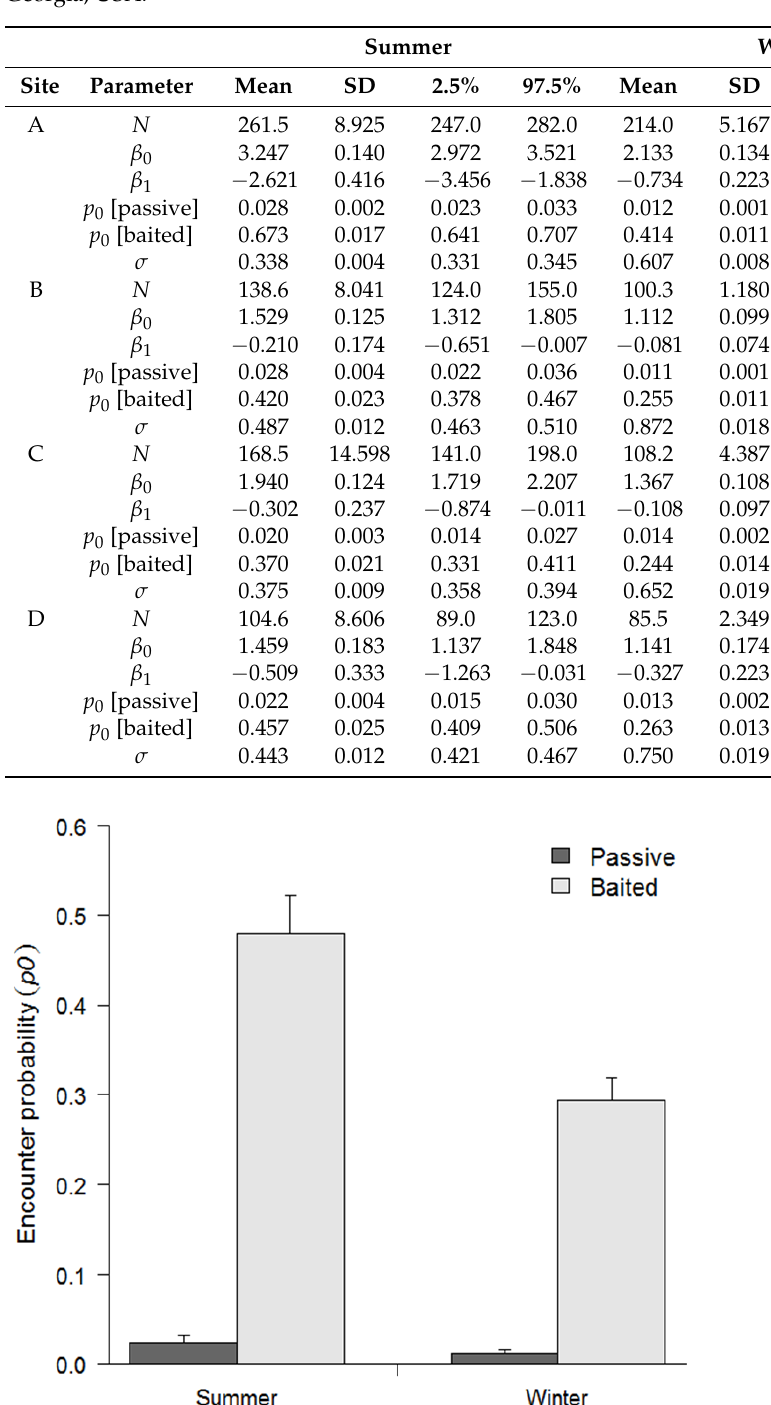
Figure 6. Encounter probabilities (95% CI) of male white-tailed deer ( Odocoileus virginianus ) cap- tured on passive and baited cameras during summer 2015 and winter 2016 surveys at four sites in southwestern Georgia, USA. Table 2. Male white-tailed deer spatial-capture recapture parameter estimates. Estimates of the pos- terior means for male white-tailed deer (Odocoileus virginianus) abundance ( 𝑁 ), intensity function intercept ( 𝛽 0 ), the effect of bait on deer activity center density ( 𝛽 1 ), baseline encounter probabilities for both passive ( 𝑝 0 [passive]) and baited cameras ( 𝑝 0 [baited]), and the scaling parameter of the half-normal detection function ( 𝜎 ) from summer (2015) and winter (2016) camera surveys in south- western Georgia, USA.